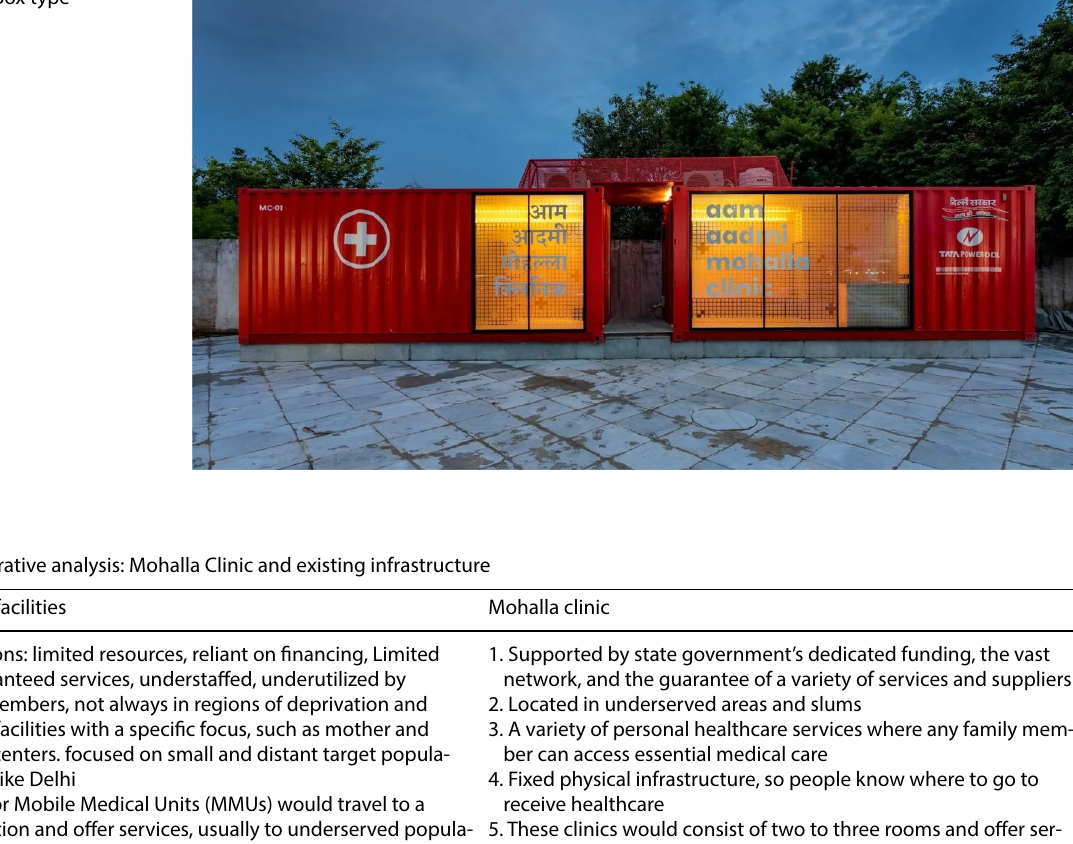
Fig. 3 Shipping container Mohalla Clinic: Box type